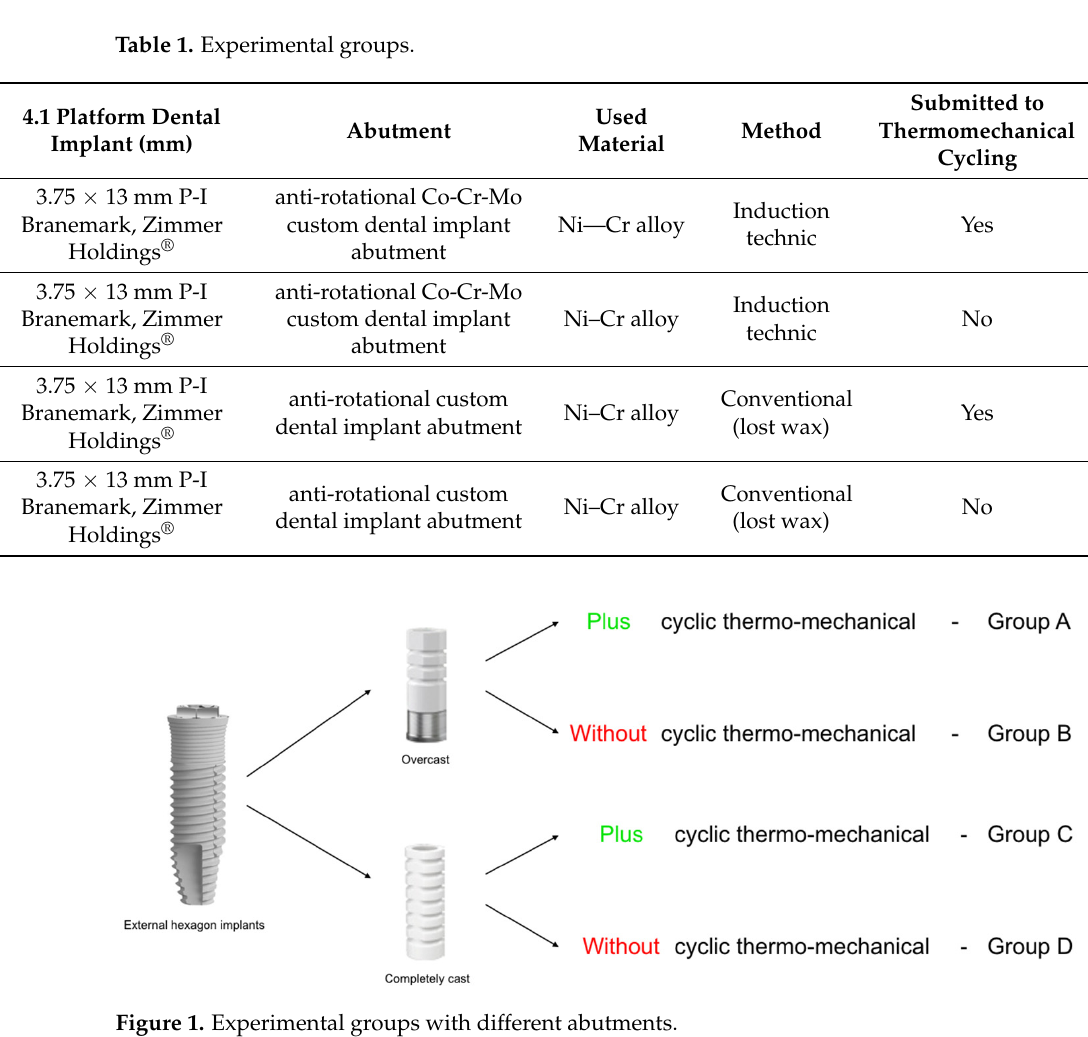
Table 1. Experimental groups.